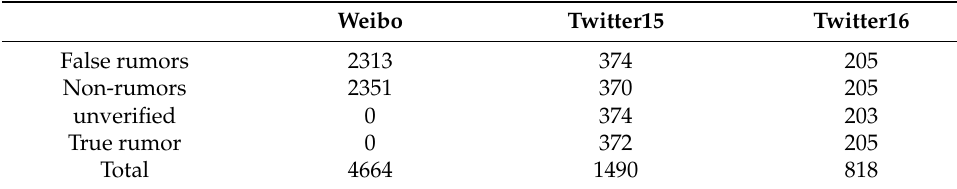
Table 1. Datasets information statistical table.